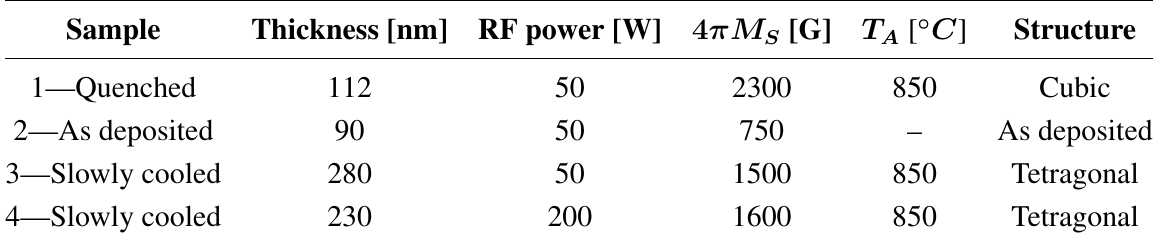
Basic parameters of the set of CuFe temperature and M denotes the saturation S